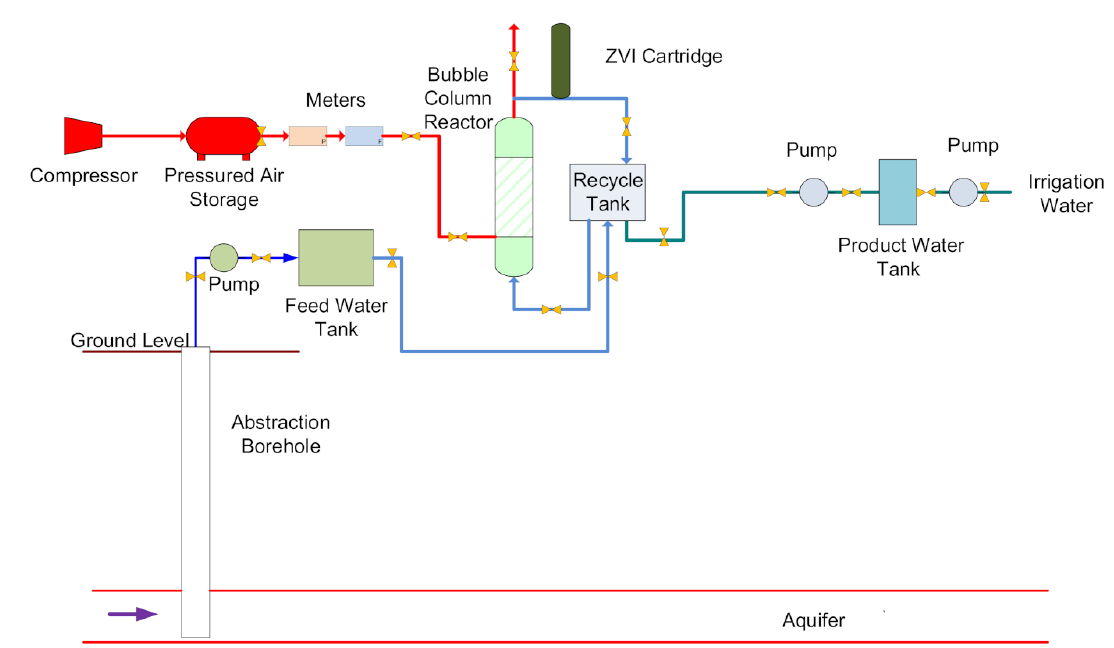
Figure 1. Process flow diagram for the reactor train used in this